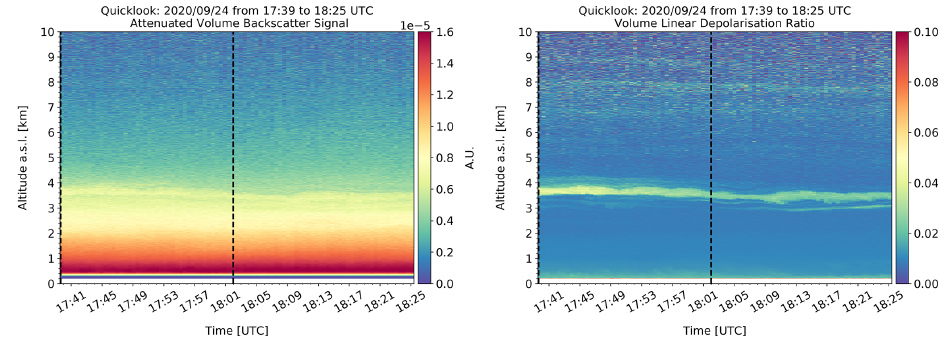
Figure 10. Height versus time plots of the attenuated volume backscatter signal from linear emission and the volume linear depolarisation ratio at 355nm over Athens, measured by eVe lidar on 24 September 2020 from 17:39 to 18:25UTC. The raw temporal and vertical resolution is 30s and 3.75m, respectively, with vertical pointing of the system. The attenuated volume backscatter signal was calibrated using a calibration factor averaged inside the selected time frame and calculated at 9.8km within a 0.2km window. The two dashed black lines enclose the selected time frame for the optical products’